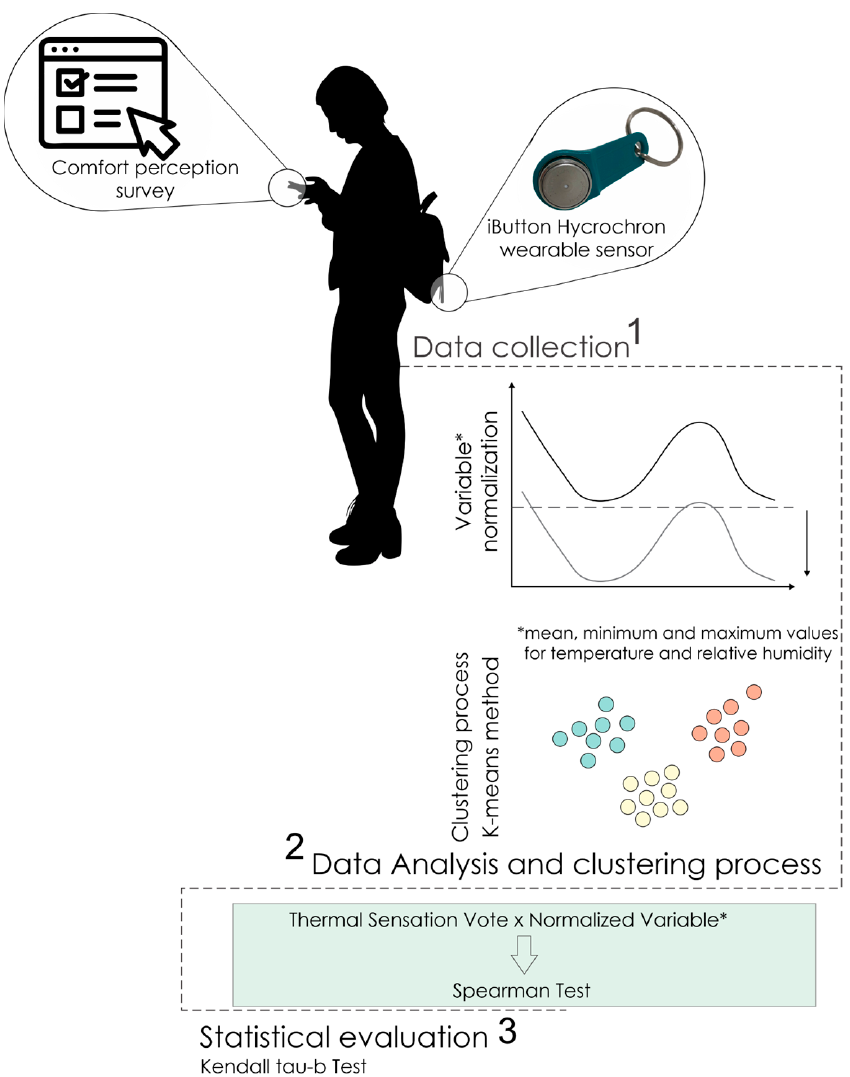
Figure 1. Research framework demonstrating steps 1 (data collection), 2 (data analysis and clustering process), and 3 (statistical calculation).